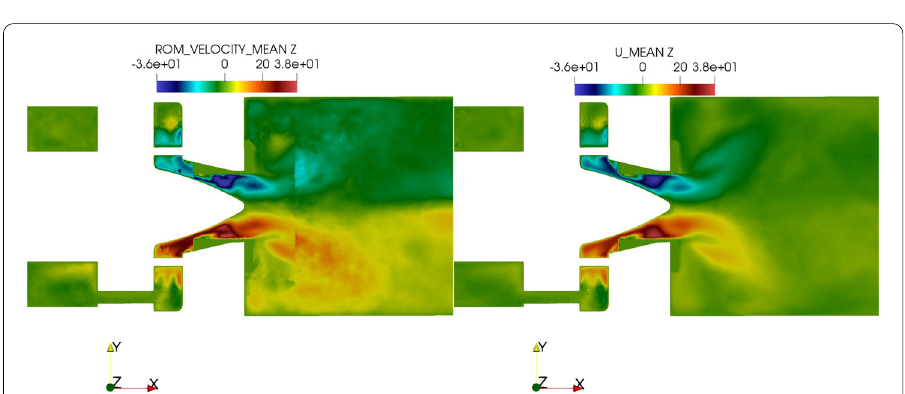
Fig. 49 Smaller RFD. On the left, the third component of the mean flow field by the UGPOD applied to configuration 1. On the right, the third component of the high fidelity mean flow field with configuration 1